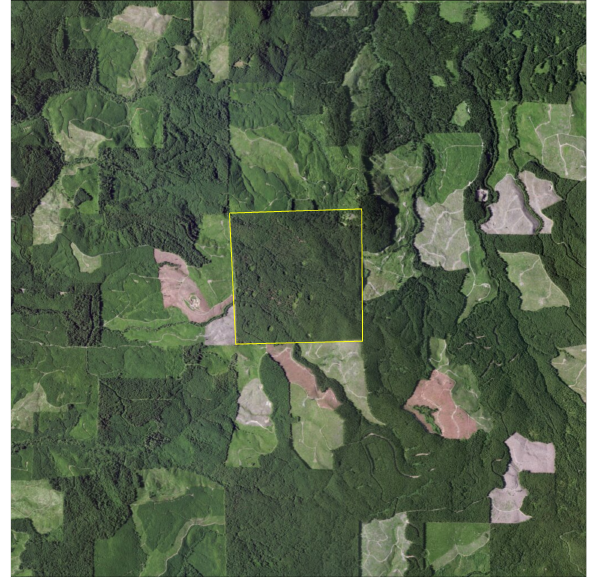
Figure 6. Aerial photograph of the Keel Mountain study site (yellow square),